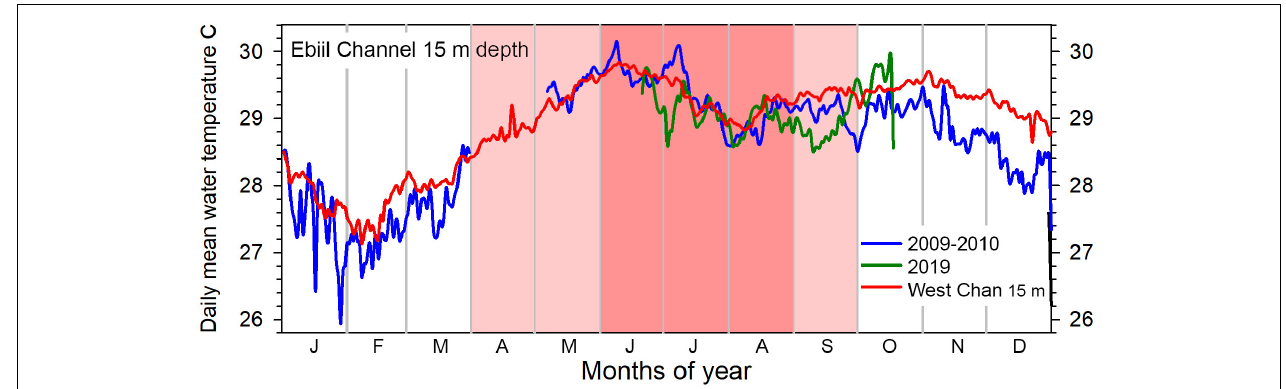
FIGURE 13 | Annual patterns of daily mean water temperature at 15 m depth, Ebiil channel. Partial cycles of temperature were recorded in 2009–2010 and 2019 with gaps in the April to early May period. Similar data from 15 m in the West Channel, south of Ebiil, for the same years show the complete annual cycle and the close similarity of data between the two sites. The 6 months (April to September) with pink shading indicate those months with P. areolatus aggregation, while the darker pink 3 months (June to August) include time of aggregation of the other two species.